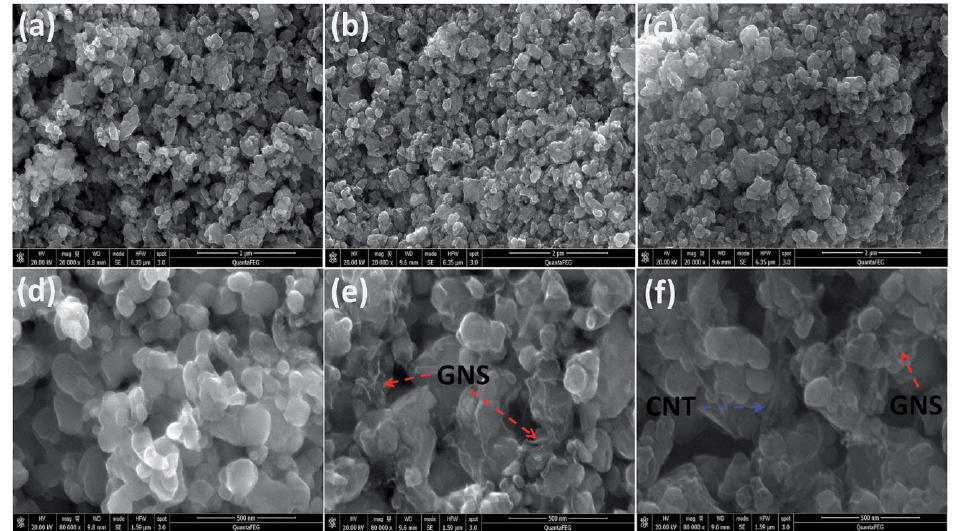
Figure 4. Scanning electron microscopy (SEM) images of ( a , d ) C-LVP, ( b , e ) C-LVP/GNS, and ( c , f ) C-LVP/(GNS+CNT). Reproduced with permission from [29]. The Royal Society of Chemistry,